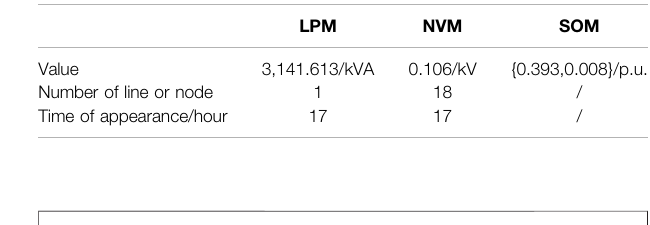
TABLE 1 | Evaluation of system operating margin.